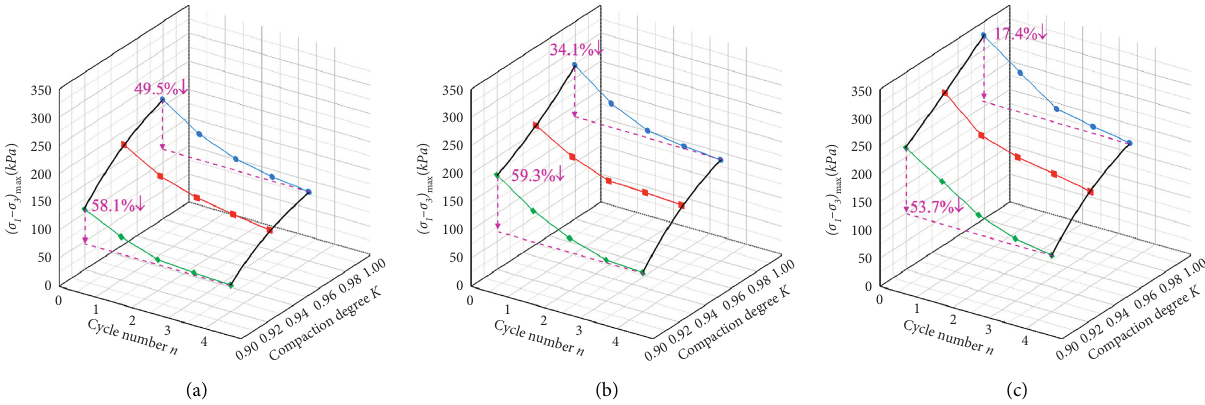
Figure 9: Strength variations of compacted residual soil: (a) σ